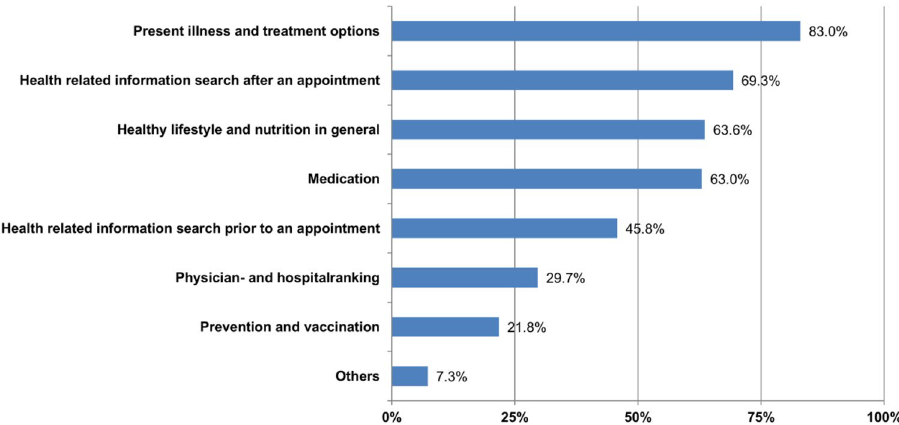
Figure 2. Online health related information search in solid organ transplant recipients in % (answers given by the 234 responders).